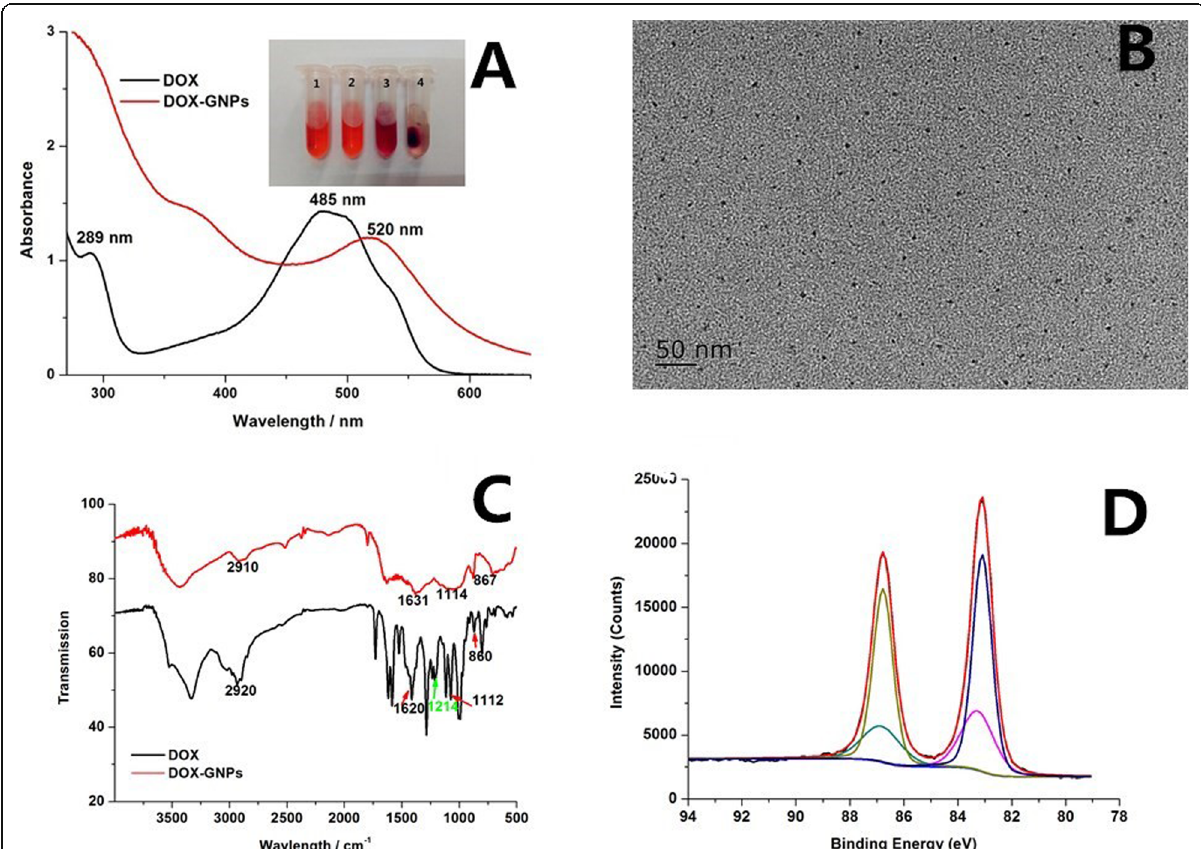
Fig. 1 a UV-Visible absorption spectra of DOX and the as-prepared DOX – GNPs, the inset of ( a ) is the images of DOX (1, 2) and DOX-GNPs (3, 4) before (1, 3) and after centrifugation (2, 4). b TEM image of DOX – GNPs. c FTIR spectra of DOX and the as-prepared DOX – GNPs. d XPS spectrum of DOX –